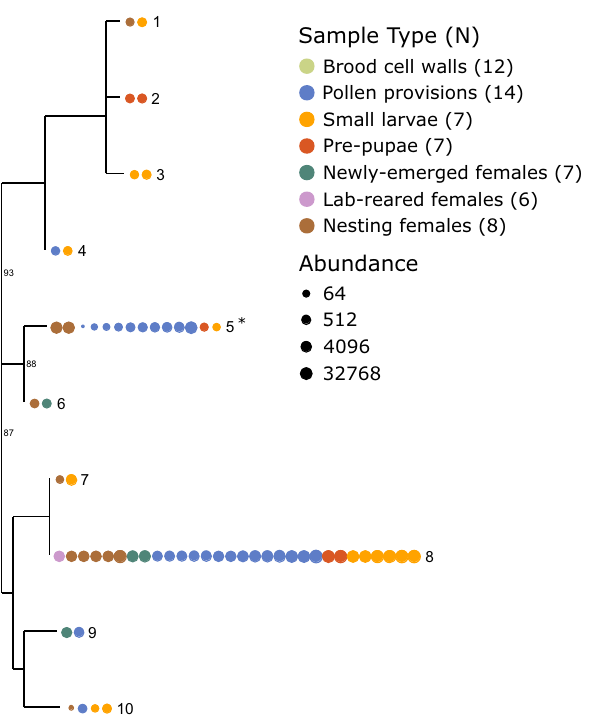
Figure 5. Diversity of Lactobacillus micheneri in alkali bees. Phylogenetic relationship of ASVs classified as L. micheneri with bootstrap support values near the nodes. Each circle represents an individual sample. Color indicates sample type and size reflects abundance on a log 2 scale. Tip label identifies the ASV in Table S2. *Signifies Lactobacillaceae identified as externally sourced in Fig. 4b,c. Numbers next to sample type indicate sample size